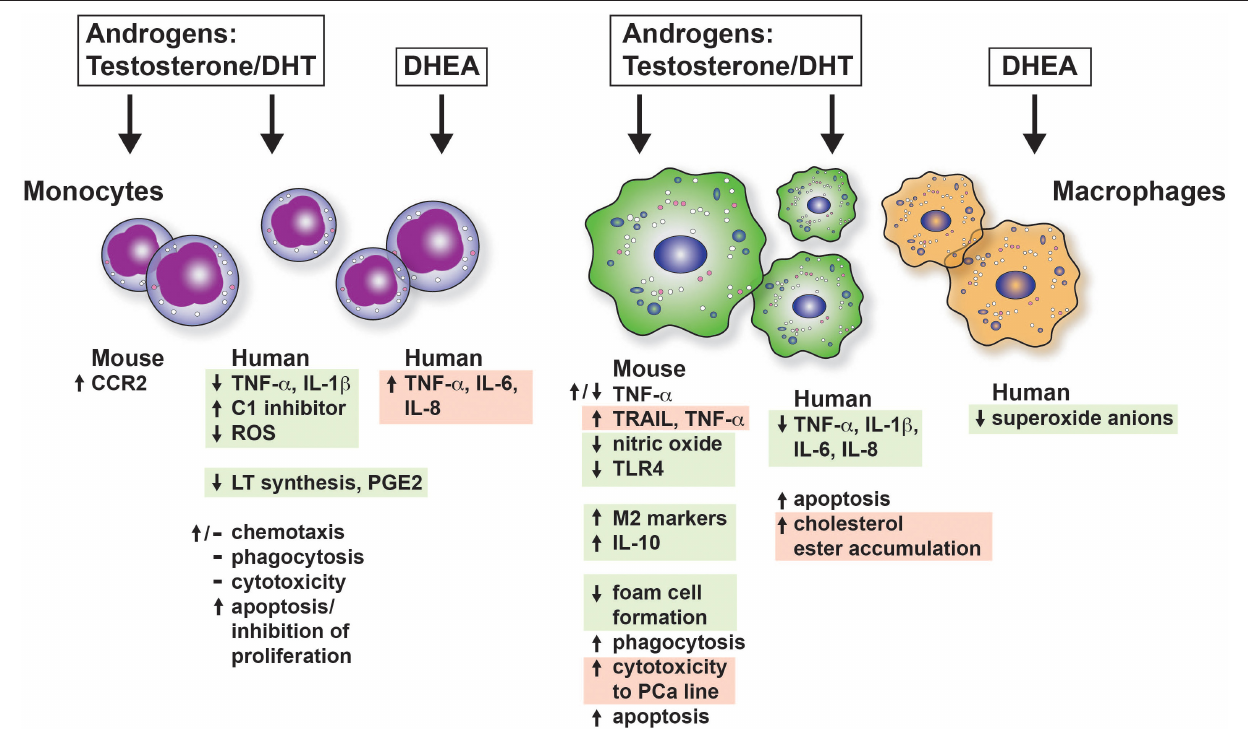
FIGURE 2 | The effects of androgens on mouse and human monocytes and macrophages in vitro . The consequences of androgen exposure of monocytes and macrophages are shown. Green boxes indicate that the effect is to dampen proinflammatory responses or be considered immunosuppressive. The red boxes indicate a response that would increase inflammation. CCR2, C-C chemokine receptor type 2; DHT, dihydroxytestosterone; DHEA, dihydroepiandrosterone; PCa, prostate cancer; PGE2, prostaglandin E2; ROS, reactive oxygen